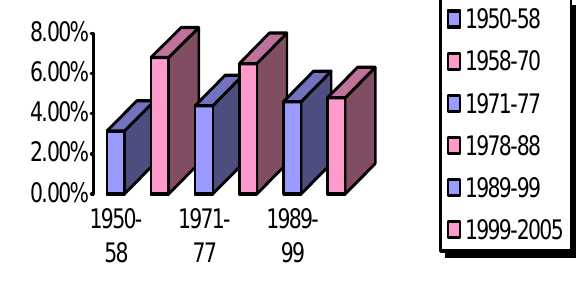
Figure 1: Average GDP Growth Rate Although Pakistan's economic